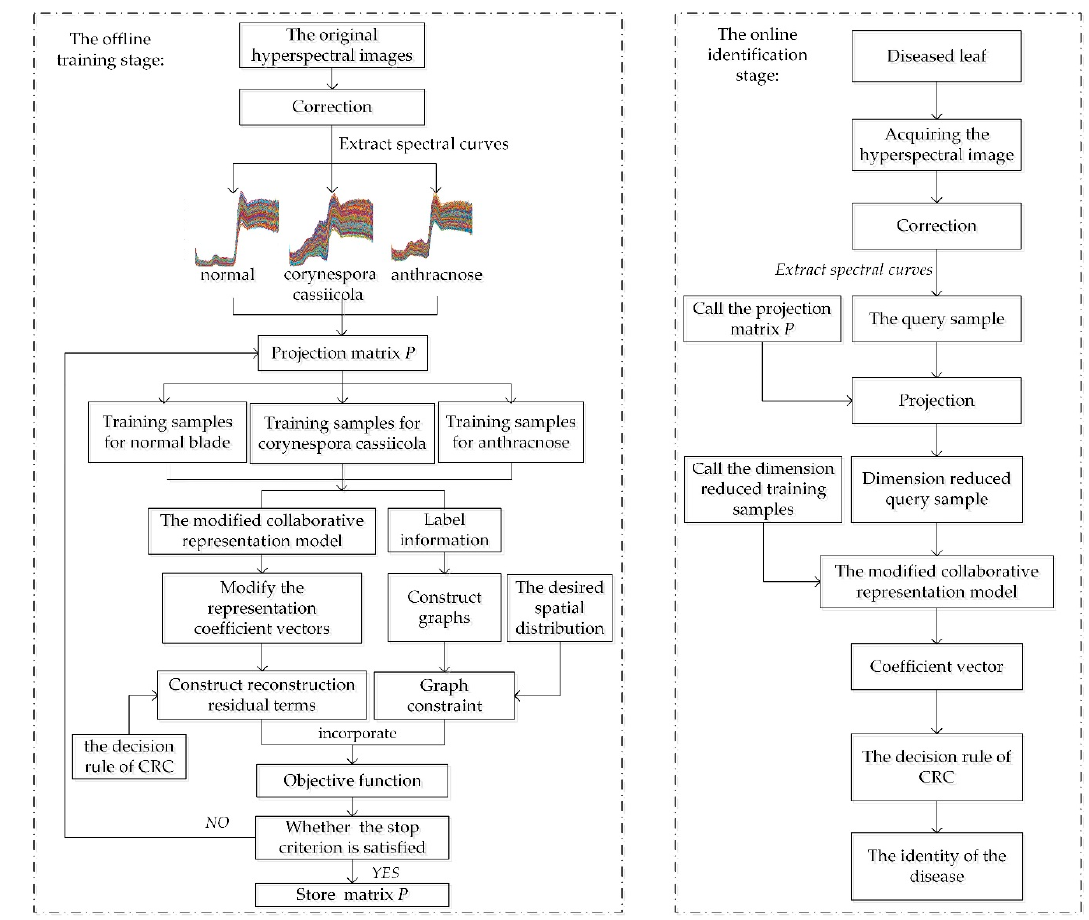
Figure 1. The flowchart of the CRC-steered discriminative projection learning method (CRC-DP).